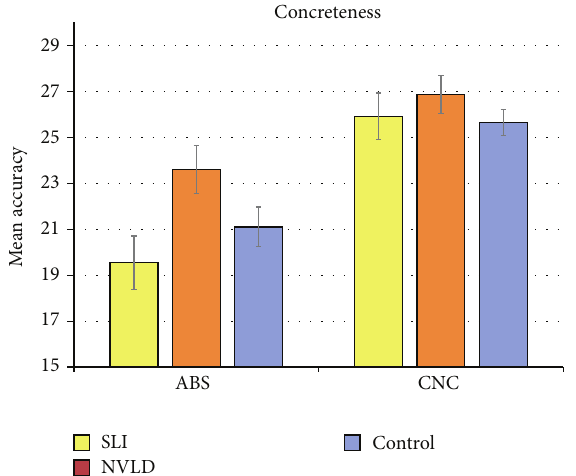
Figure 1: Mean accuracy scores for concrete and abstract verb- object combinations in the three groups. Error bars represent standard errors.